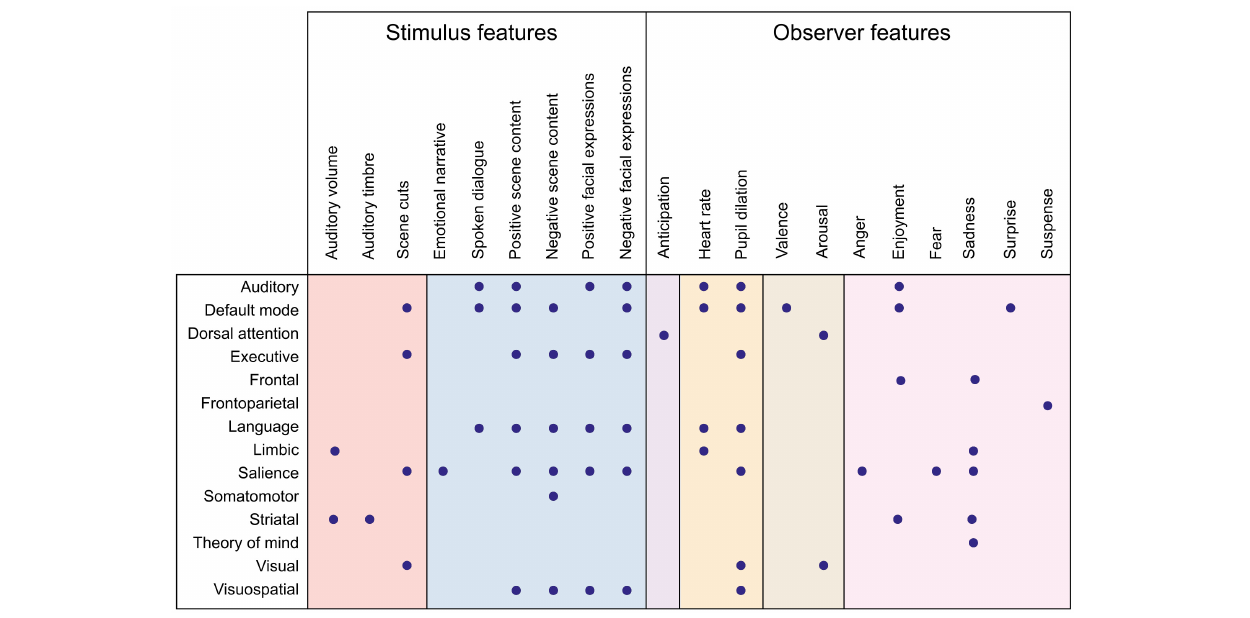
FIGURE 3 | Summary of functional networks correlating with emotion features. Dots denote an observed association between the network (rows) and the emotion feature (columns). Color panels denote feature categories (from left to right): low-level auditory and visual features (red), object-level features (blue), emotion elicitation (violet), interoception (orange), affective dimensions (brown), and emotion categories (pink). Directionality of association and more detailed anatomical locations are listed in Supplementary Table 2